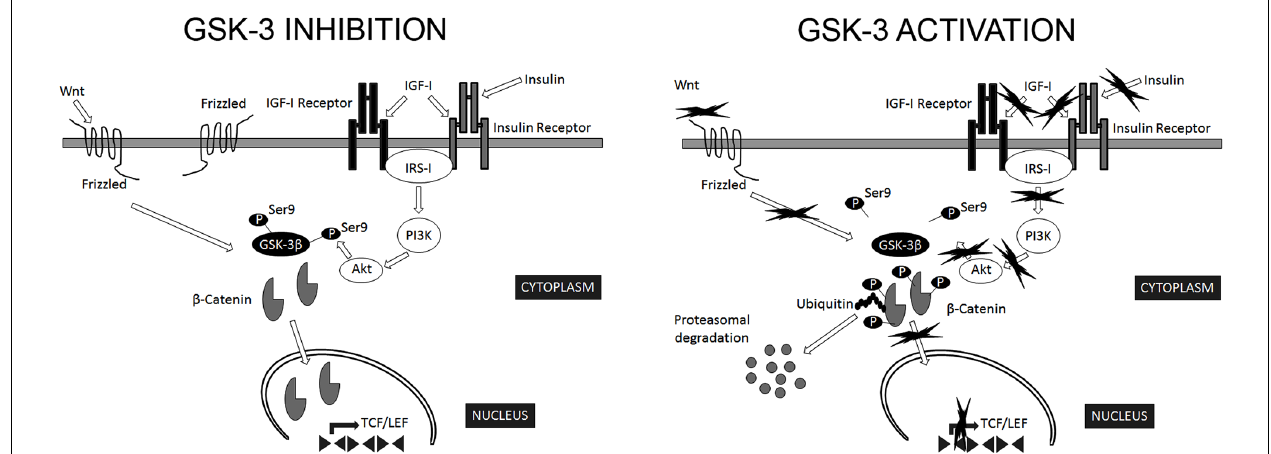
FIGURE 1 | Regulation of GSK-3 β activity. GSK-3 β is constitutively active in most tissues and most commonly regulated by inhibitory phosphorylation on Ser9. The most relevant extracellular signaling pathways known to negatively regulate GSK-3 β activity are those of insulin/insulin-like growth factor I and Wnt. In the canonical Wnt signaling pathway, Wnt stabilizes levels of β -catenin. Subsequently, stabilized β -catenin initiates the transcription of target genes. GSK-3